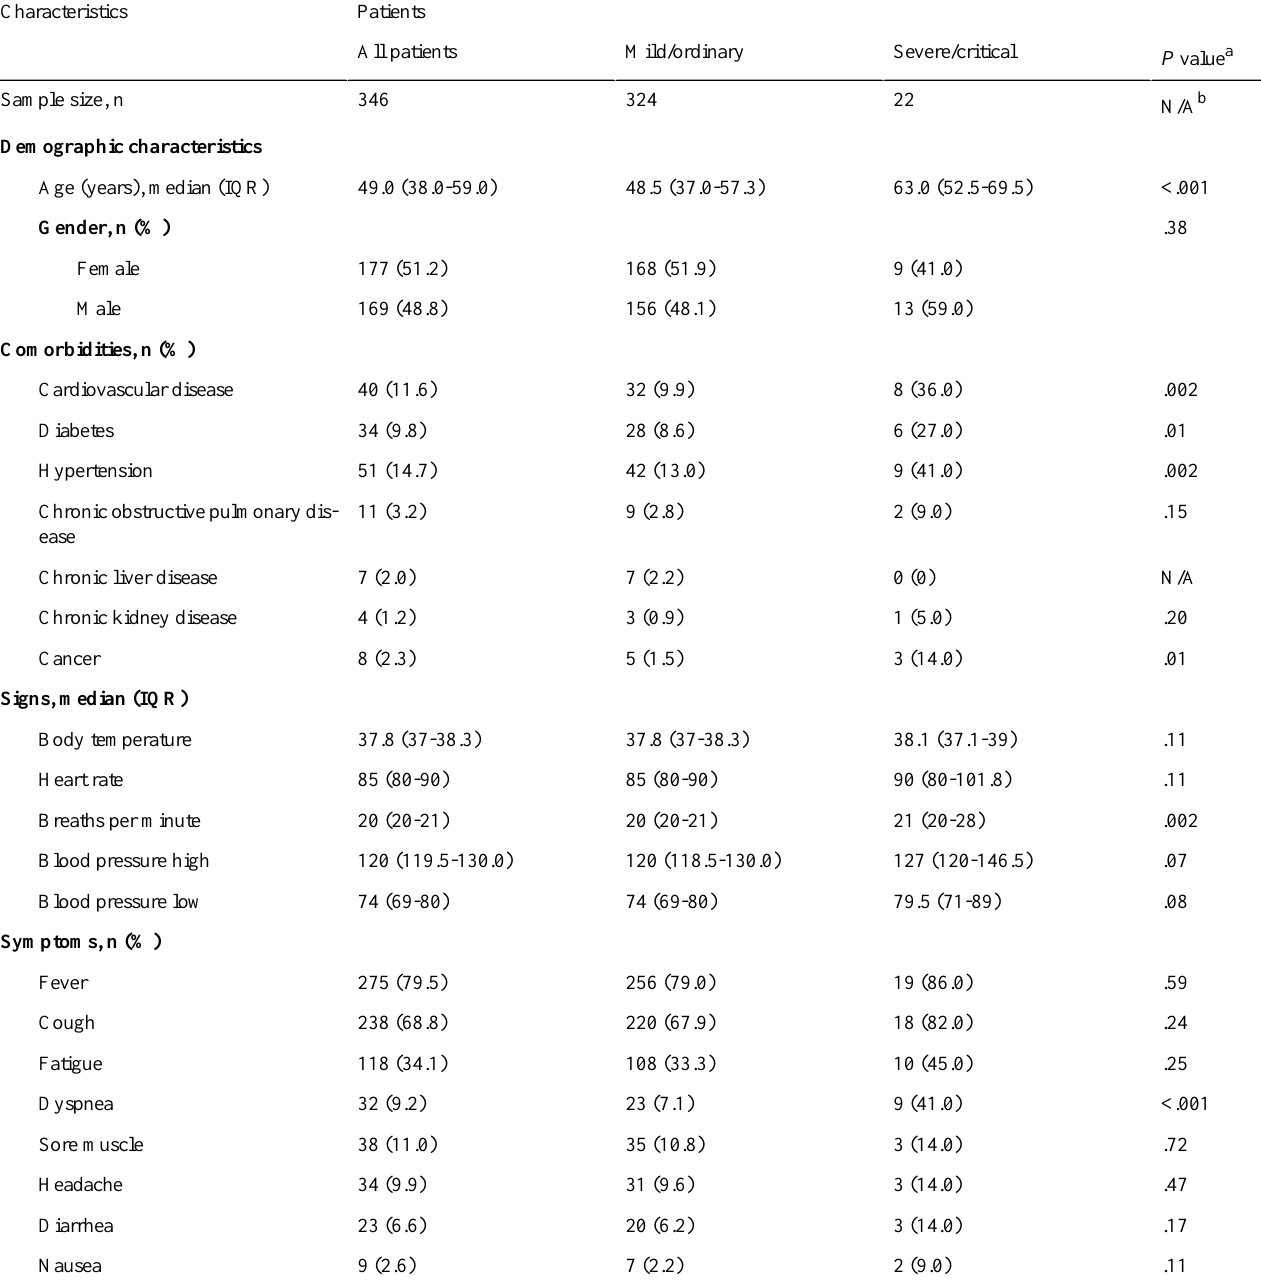
Table 2. Demographics and baseline characteristics of patients with confirmed COVID-19 (N=346). Symptoms including cardiovascular disease and shortness of breath were more likely in cases of severe/critical